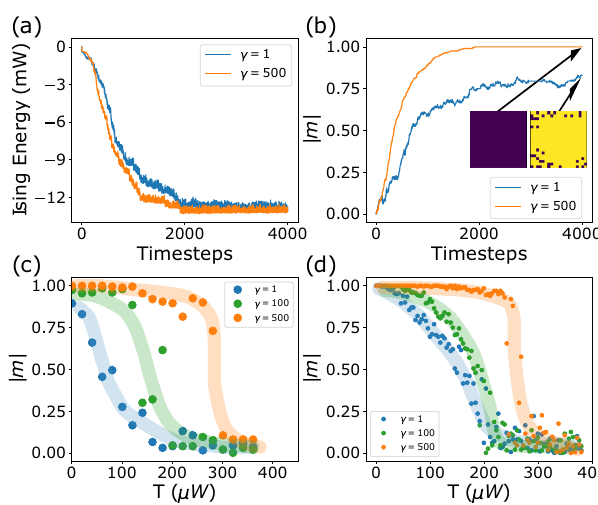
Fig. 2 Ground state energy and magnetization of the nonlinear optical Ising machine. a Experimentally measured Ising energy and ( b ) magnetization of the spin model as a function of the Monte-Carlo iterations for four-body coef fi cient γ = 1 (blue) and 500 (orange). The inset of panel ( b ) shows the converged spin con fi gurations of the Ising model at the end of the time evolution, with the blue and yellow pixels corresponding to opposite spins. c Experimentally measured magnetization as a function of temperature for γ = 0, 100, 500. d The same results obtained from full Monte-Carlo numerical simulation. Error bars in each measurement are less than the size of the dots. Errors in the experiment could be arise due to the slight laser power fl uctuations, temperature variation, and optical misalignment, etc. In ( c , d ), the magnetization drops to zero continuously at γ = 1 (blue), 100 (orange) and abruptly at γ = 500 (green) with the thick lines the guides to the eyes.